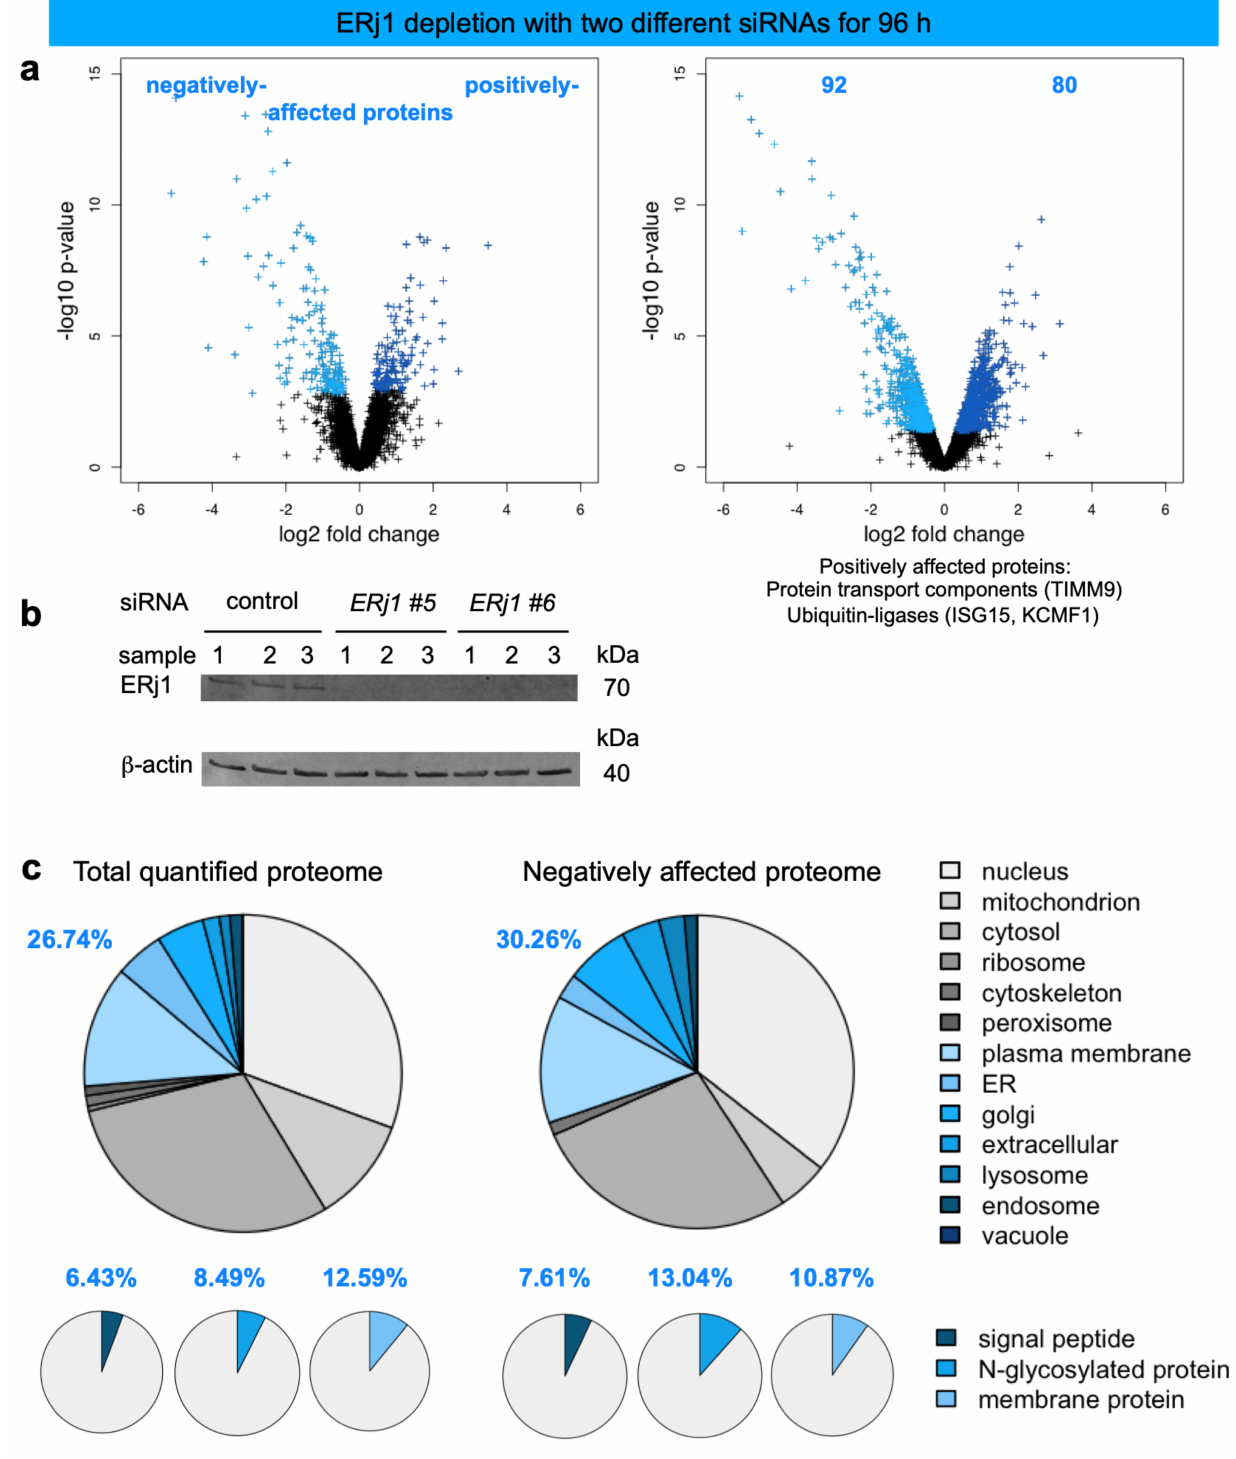
Figure 7. Volcano plots and GO enrichment after ERj1 depletion. ( a ) Differentially affected proteins were characterized by the mean difference of their intensities plotted against the respective permutation false discovery rate-adjusted p -values in volcano plots. The results for a single targeting siRNA are shown in each panel. ERj1 was not among the quantified proteins. The numbers of proteins, which were negatively or positively affected by both targeting siRNAs, are given in the right panel; the full set of relevant positively affected proteins are given below the right plot. ( b ) Knock-down efficiencies were evaluated by western blot. Molecular mass values are indicated in kilodaltons (KDa). Only the area of interest of